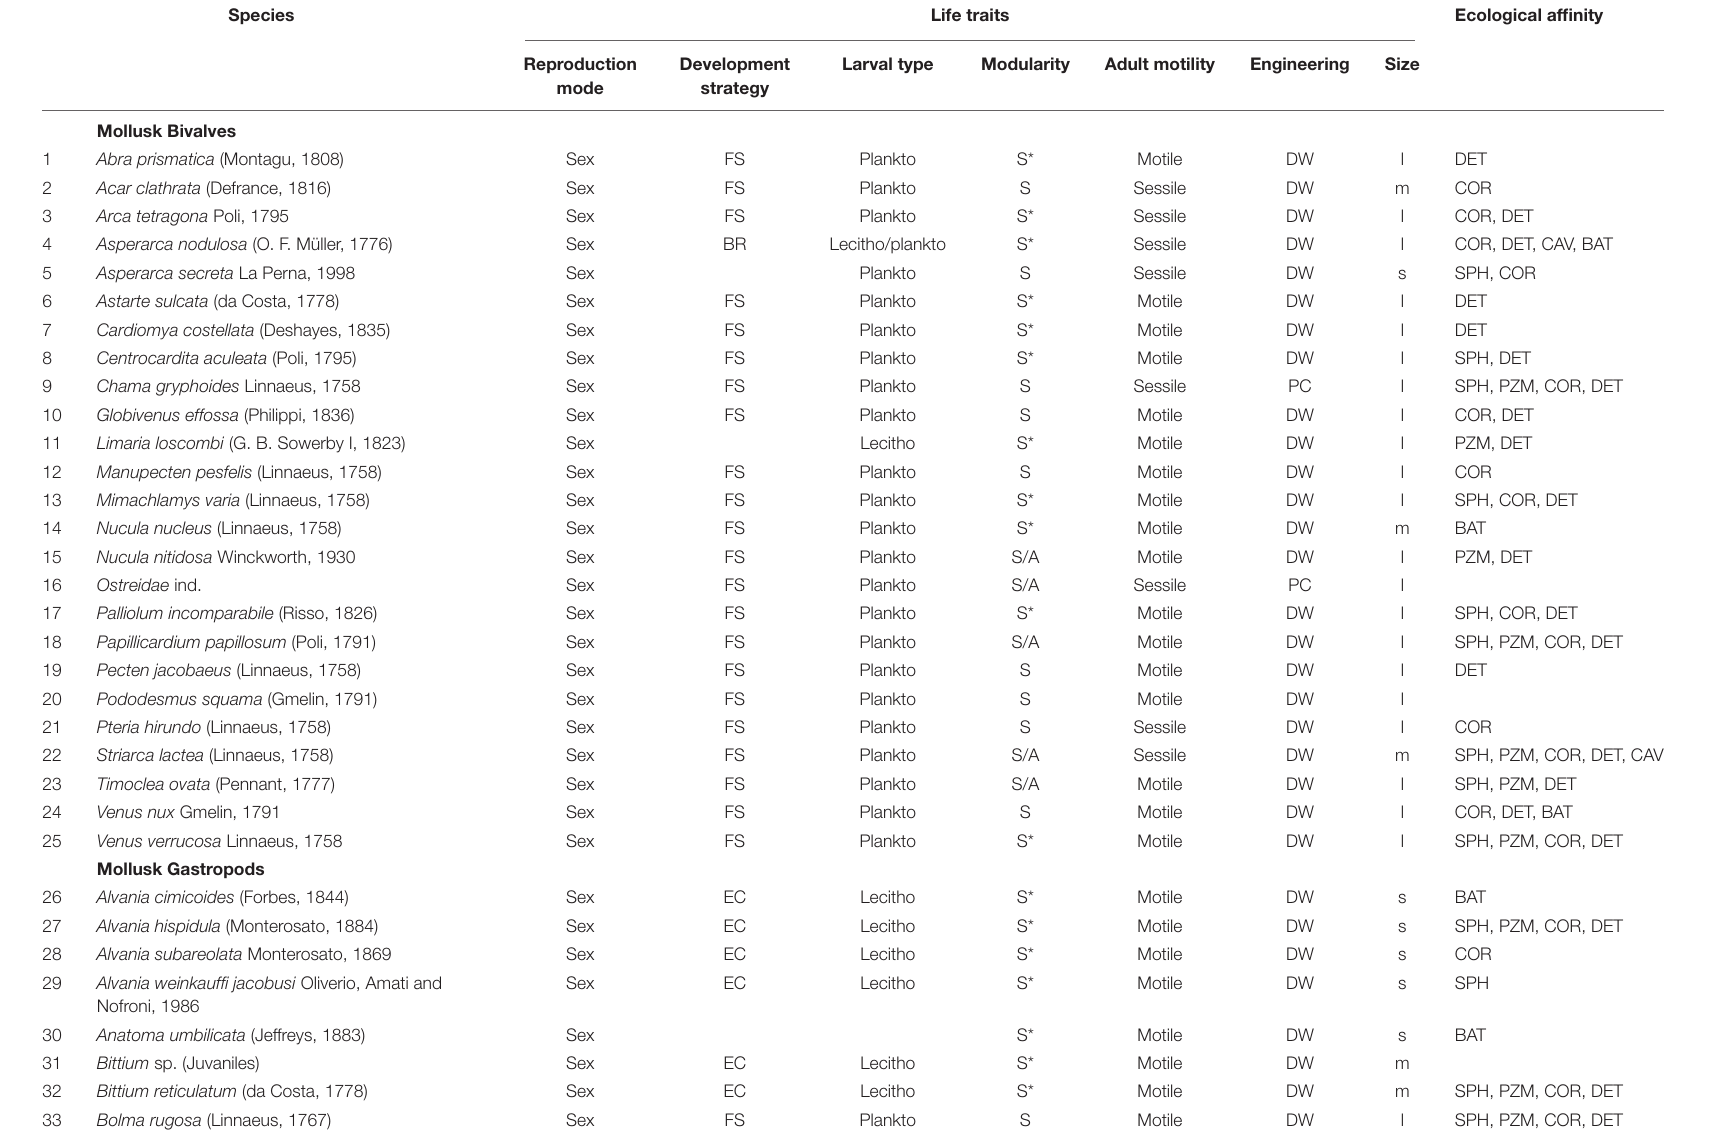
TABLE 1 | List of the identified species and their life-history traits and ecological affinities. Species Life traits Ecological affinity Reproduction